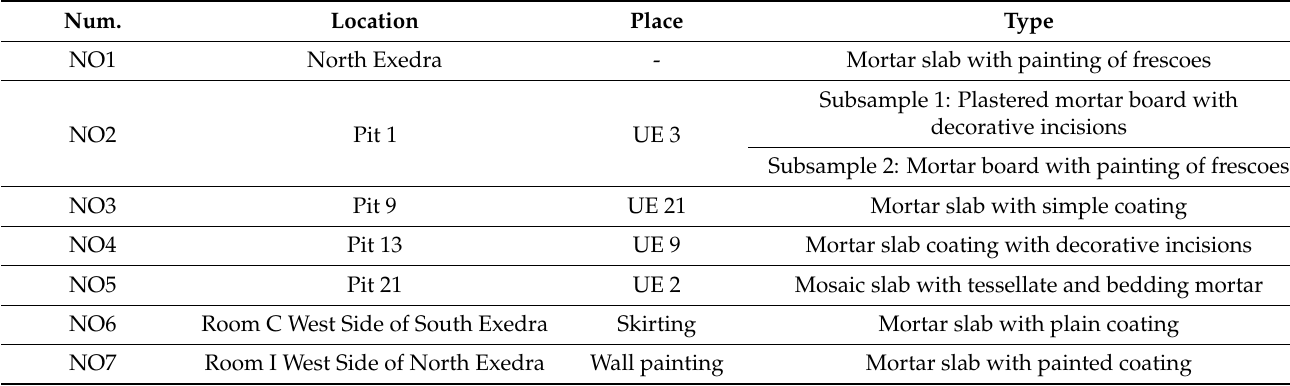
Table 1. Distribution of the samples, provenance, and